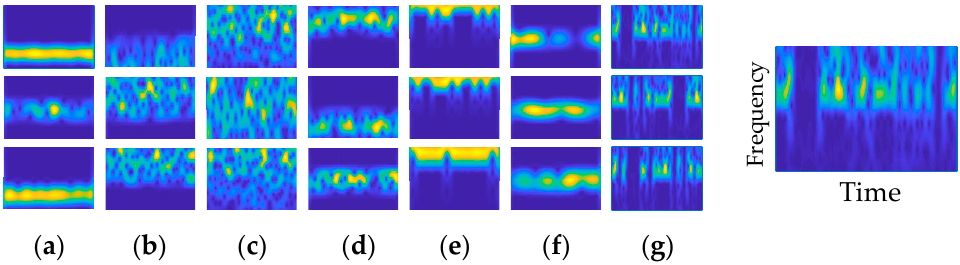
Figure 2. Time-frequency maps, where the horizontal axis represents time and the vertical axis represents frequency. ( a ) 2FSK; ( b ) 16QAM; ( c ) 64QAM; ( d ) BPSK; ( e ) MSK; ( f ) QPSK; ( g ) 2ASK.